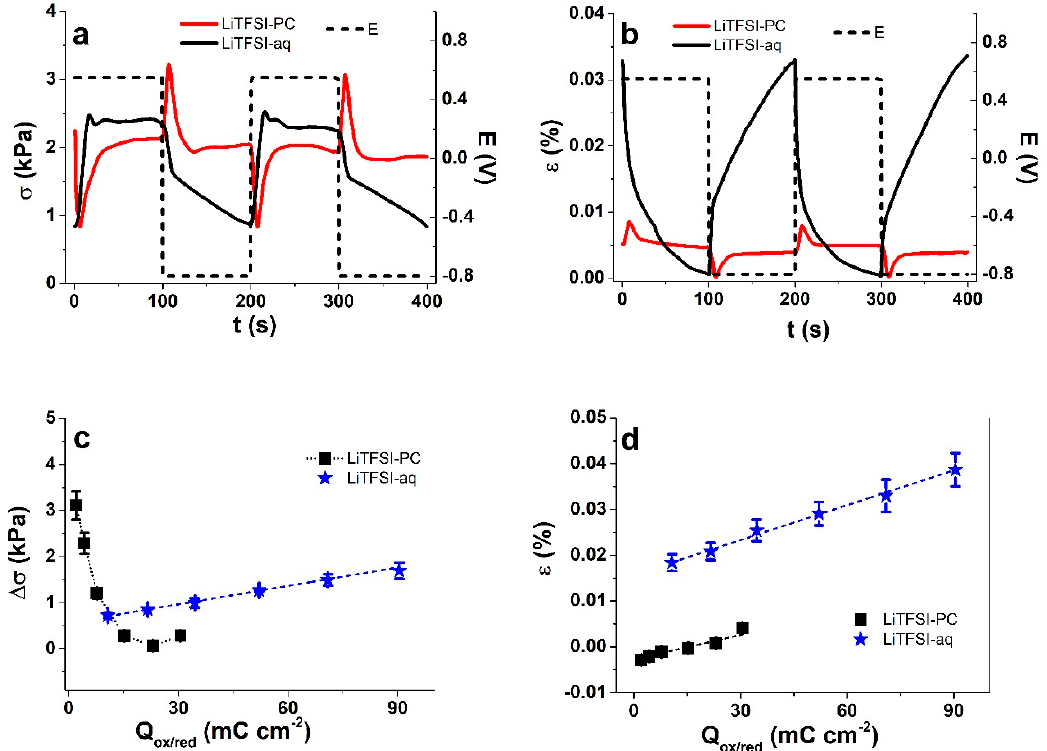
Figure 4. (a) Stress and (b) strain of Cell-CNT fibers in square wave potential step measurements in LiTFSI-PC (red, dotted) and LiTFSI-aq (black, solid) with equal LiTFSI concentration. Presented are two subsequent cycles (2nd and 3rd) at 0.005 Hz. Charge densities Q of Cell-CNT fibers in LiTFSI-PC ( ■ ) and LiTFSI-aq ( ★ ) at different applied frequencies (shown in Figure S2a,b) against (c) stress difference Δσ and (d) strain ε (negative values of strain indicate expansion at charging, positive values show expansion at discharging). The linear fit (dashed blue) of Cell-CNT in LiTFSI-aq ( c ) and ( d ) are shown for orientation only.